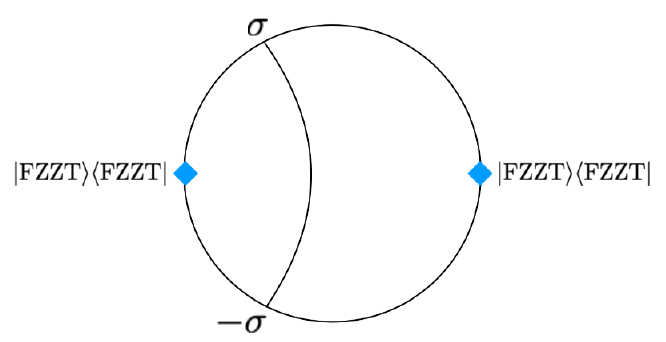
Figure 7. The con(cid:12)guration of the insertions in the case of two FZZT